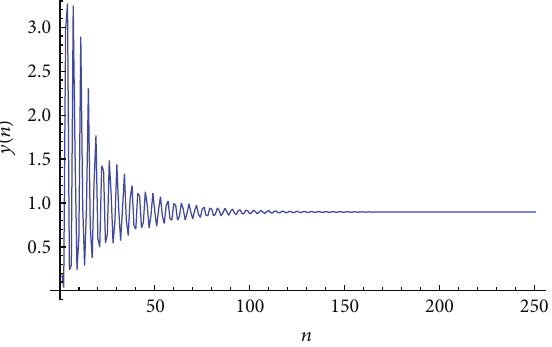
Figure 1: Plot of 𝑥 𝑛 for the system (51).